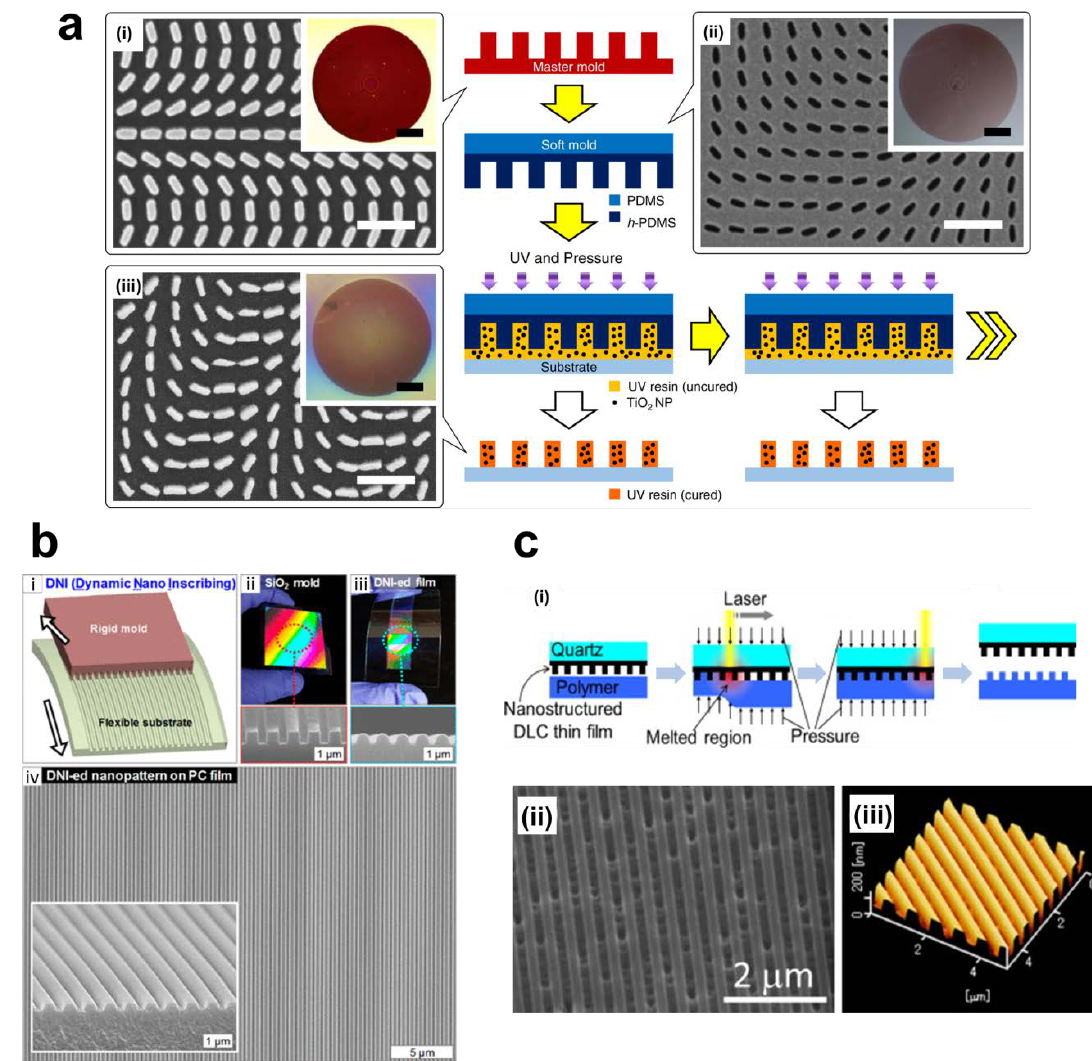
Figure 10. ( a ) Schematic of the plum pudding metasurfaces. Titanium dioxide nanoparticle composite resin is cured by PDMS and hard PDMS molds. The SEM images of (i) master mold, (ii) soft mold, and (iii) final metalens. All scale bars are 100 μm [2]. ( b ) (i) Mechanism of the DNI process, (ii) a rigid nanograting mold, (iii) a inscribed nanopattern on a flexible substrate, (iv) the SEM image of a nanopattern using the DNI. Inset indicates the enlarged perspective view [185]. ( c ) Laser-assisted large-area nanoimprint method and its results. (i) Schematics of laser-scanning replication, (ii) the